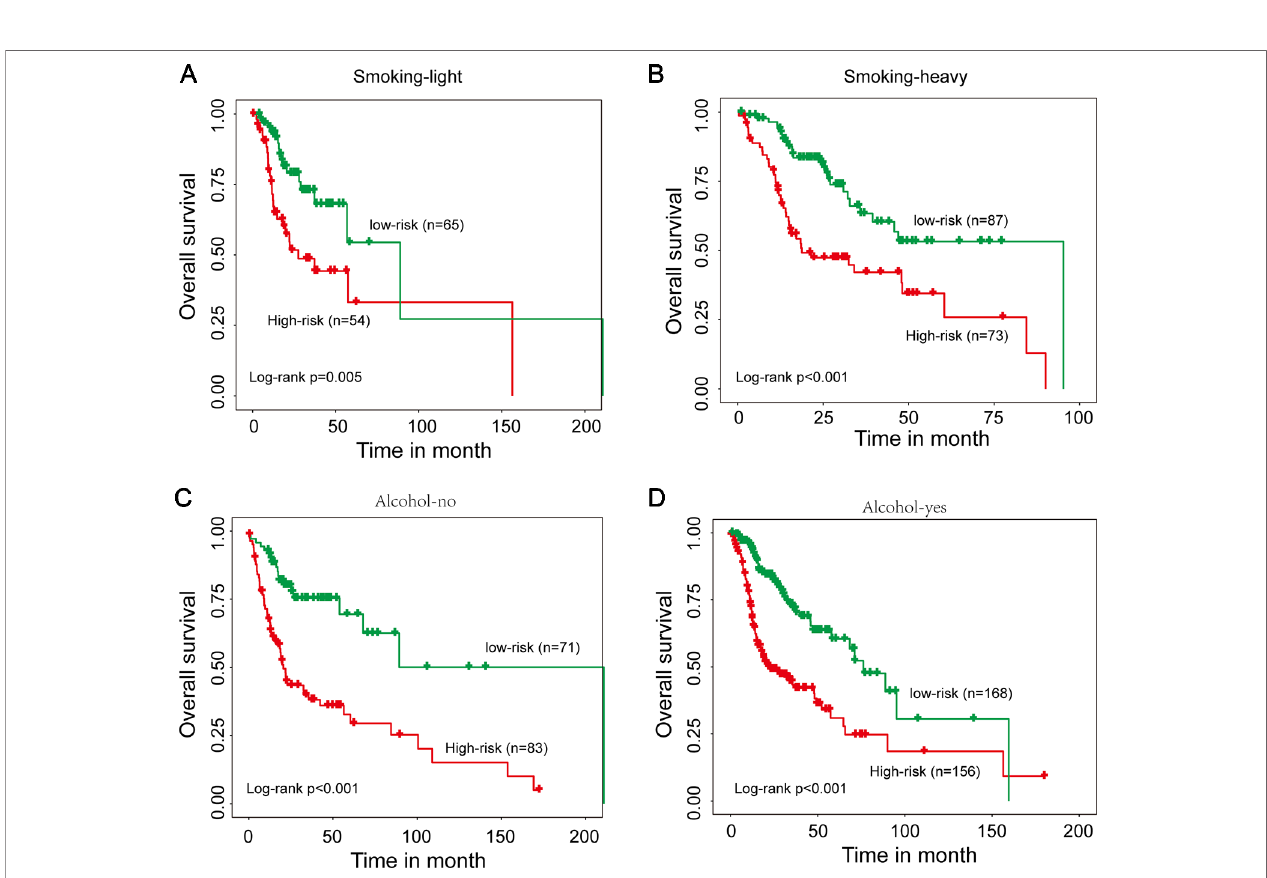
FIGURE 5 | Strati fi cation analysis for smoking and alcohol. (A) Kaplan – Meier survival curves of overall survival between the high-risk group and low-risk group for smoking-light patients. (B) Kaplan – Meier survival curves of overall survival between the high-risk group and low-risk group for smoking-heavy patients. (C) Kaplan – Meier survival curves of overall survival between the high-risk group and low-risk group for alcohol-no patients. (D) Kaplan – Meier survival curves of overall survival between the high-risk group and low-risk group for alcohol-yes